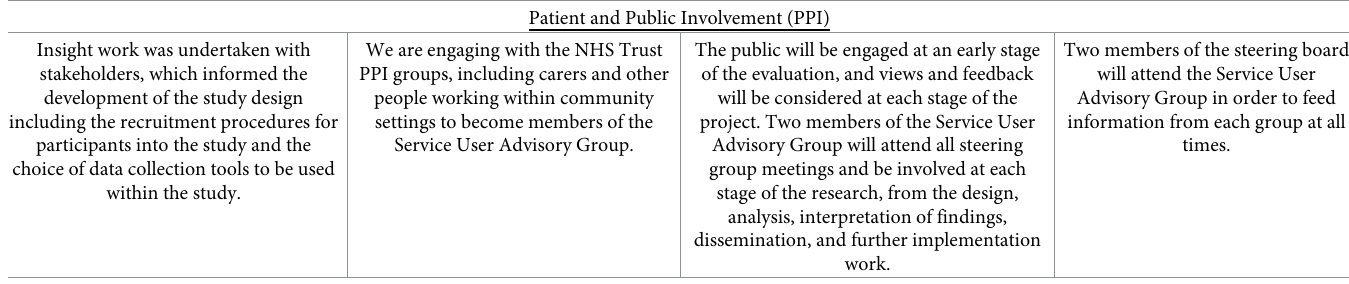
Table 2. Patient and Public